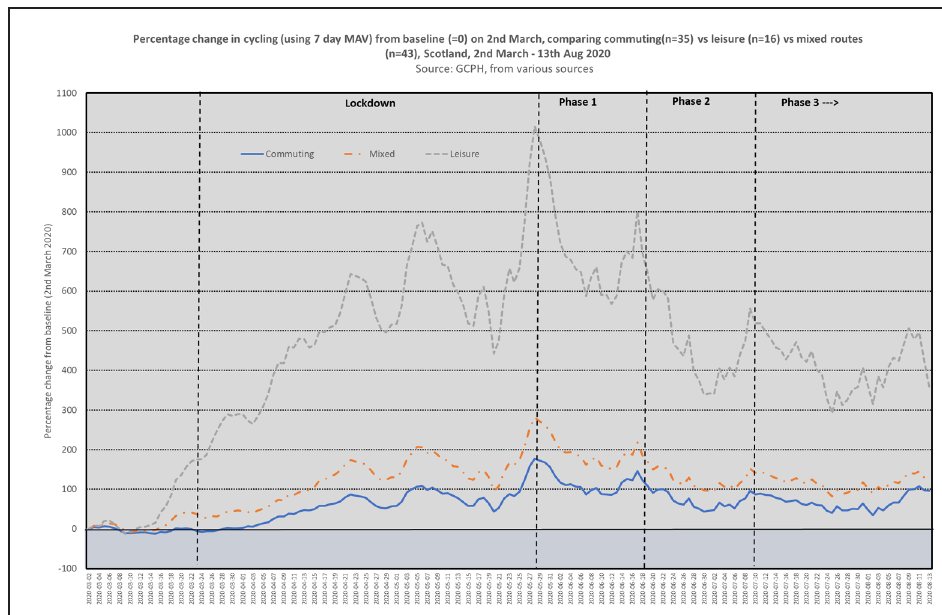
Figure 4: Percentage change in cycling from baseline on March 2 on commuting, leisure and mixed routes in Scotland, March 2–August 13,